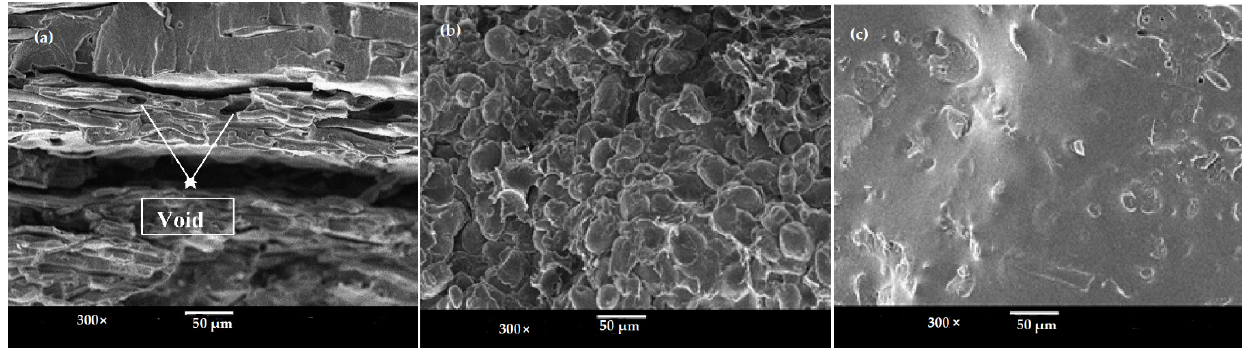
Figure 9. SEM micrographs of ( a ) untreated TPS/PS, ( b )TPS/PS/SA, and ( c ) TPS/PS/AA with 80/20 proportion blends.